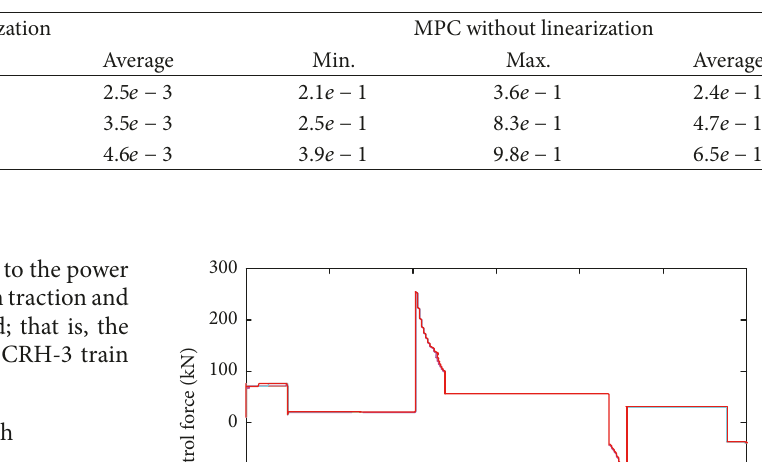
Table 6: Computational time (s) of each MPC step with and without linearization.